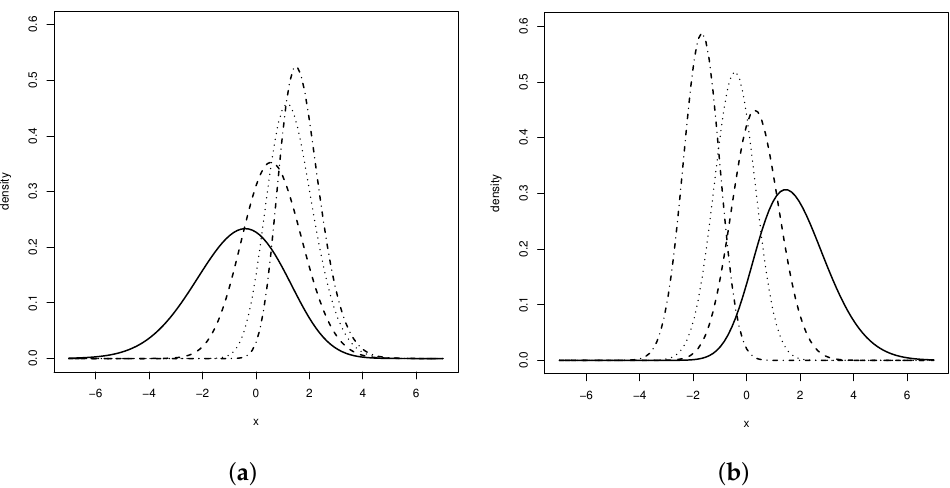
Figure 1. PDF of the LGN distribution: ( a ) δ = 0.6 and γ = 0.30 (dotted line), 0.60 (dashed line), 1.0 (dotted–dashed line), 3.0 (long dashed line) and 6.0 (solid line). ( b ) γ = 1.5 and δ = 0.30 (dotted line), 0.60 (dashed line), 1.0 (dotted–dashed line), 2.0 (long dashed line) and 5.0 (solid